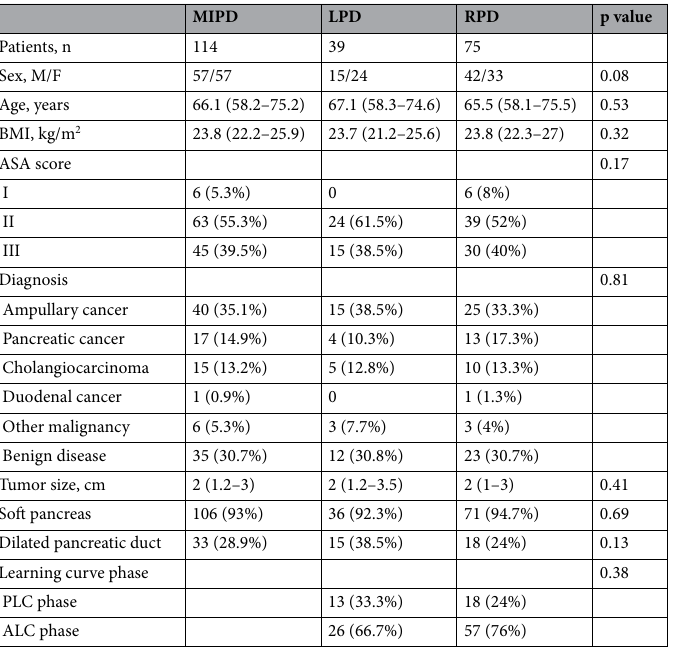
Table 1. Patient demographics of MIPD. BMI body mass index, ASA American Society of Anesthesiology, PLC pre-learning curve, ALC after-learning